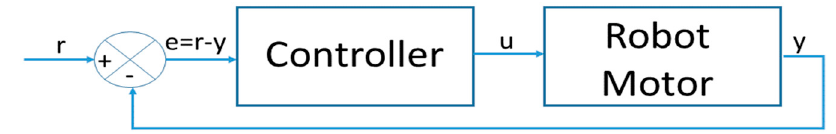
Figure 2. Closed loop controller system.